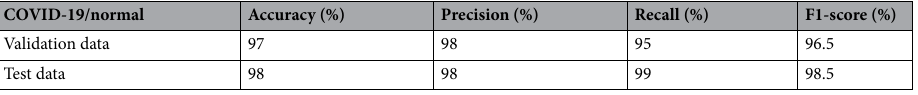
Table 1. Classification performance obtained by enhanced VGG16 on X-ray images: COVID-normal.